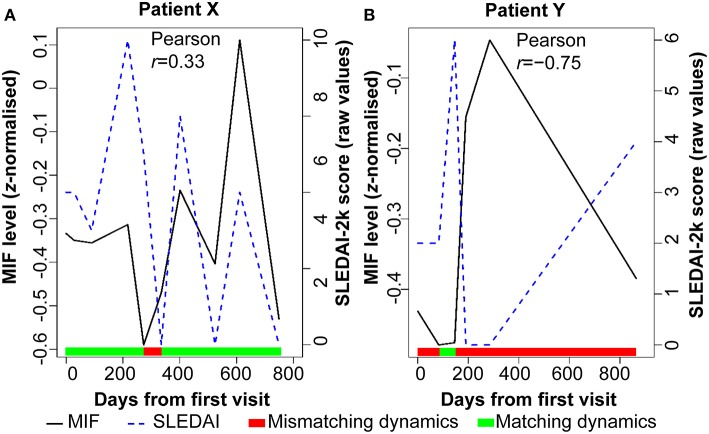
Disease activity and serum MIF levels for two SLE patients over time. The color bar indicates when the serum MIF and SLEDAI-2k dynamics are synchronized (green) or desynchronised (red). (A) Patient X has a moderate correlation between disease activity (SLEDAI-2k) and serum levels of MIF protein. (B) Patient Y has a complete lack of correlation between these two parameters. Serum MIF levels are shown as z-normalized values.